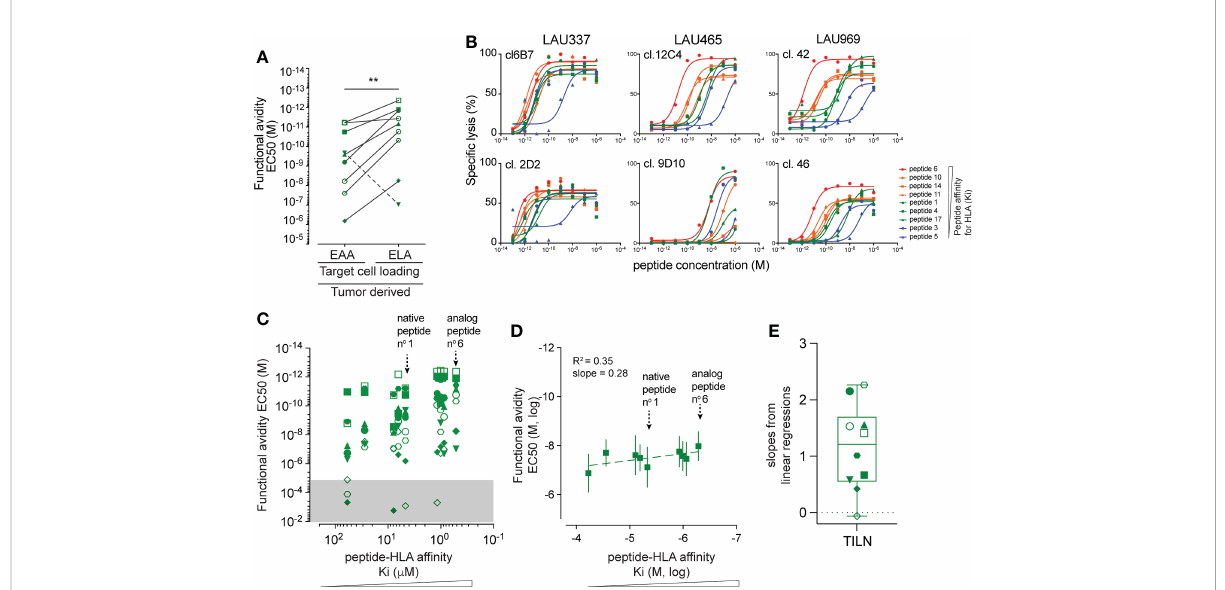
FIGURE 3 Characterization of peptide reactivity by naturally tumor-primed Melan-A-speci fi c T cell clones. (A) Comparison of the functional avidity (EC 50 ) of naturally tumor-primed Melan-A speci fi c T cell clones (n=10) during parallel killing assays with targets presenting either native (EAA) and analog (ELA) peptide. Symbols represent individual T cells clones isolated from the TILNs of three untreated patients with natural Melan-A speci fi c CD8 T cell responses. (B) Curves obtained from parallel cytotoxic killing assays of six clones isolated from three cancer patients against targets presenting nine Melan-A peptide variants with increasing K i af fi nity for HLA-A2. (C) Association analysis between functional EC 50 avidity of TILN-derived clones and K i af fi nity values of the target peptide variants. The EC 50 values in the gray area represent very low functional avidity and were excluded from further analysis. Symbols represent individual T cells clones. Native peptide n°1 and analog peptide n°6 are indicated. (D) Correlation analysis between the mean EC 50 values obtained from TILN-derived T cell killing assays against a given target variant and the K i af fi nity values of the respective peptide variants (n = 10). Average R square and slopes of the linear best fi t regression line are given. Native peptide n°1 and analog peptide n°6 are indicated. (E) Projection of the slopes ( D Y/ D X) obtained from linear regressions of the individual TILNs- derived T cells clones. Whisker box (5 th and 95 th percentile) with individual points, mean and error bars is shown. **p ≤